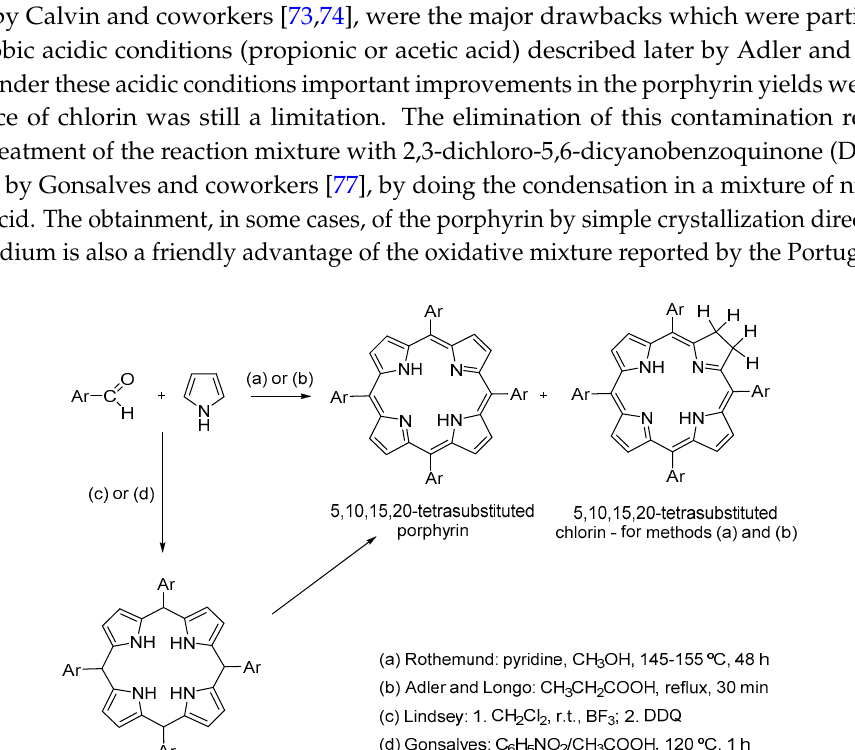
the reaction mixture with 2,3-dichloro-5,6-dicyanobenzoquinone (DDQ) [76] or, as reported by